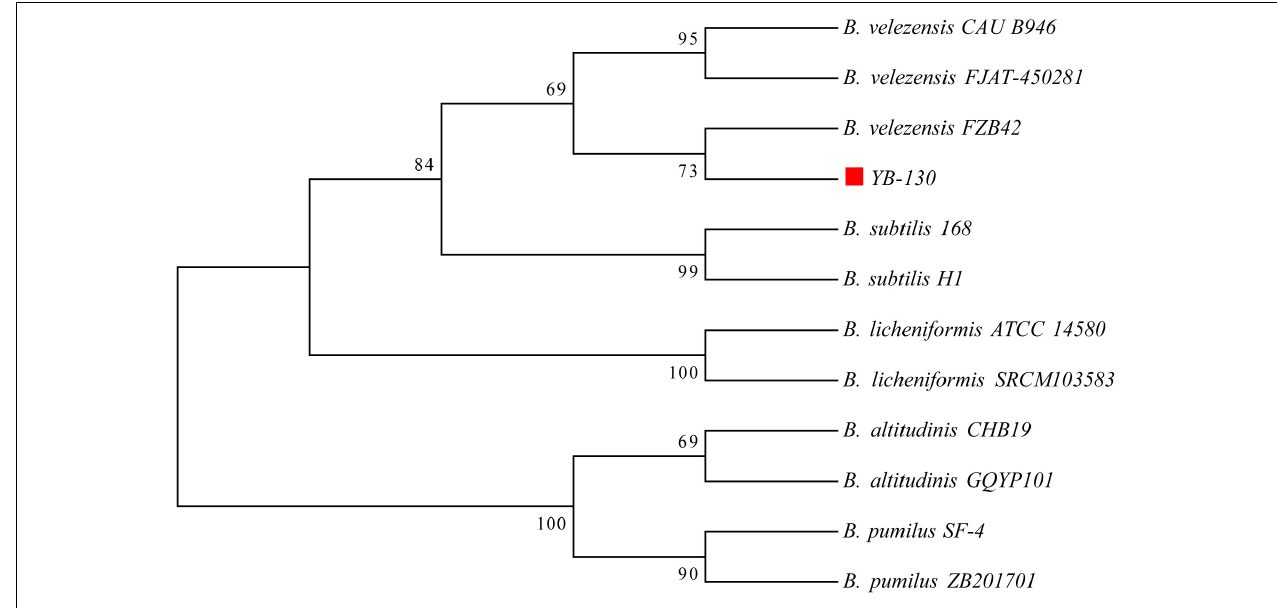
FIGURE 5 | Phylogenetic tree of strain YB-130 and other 11 Bacillus species based on 16S rRNA sequence